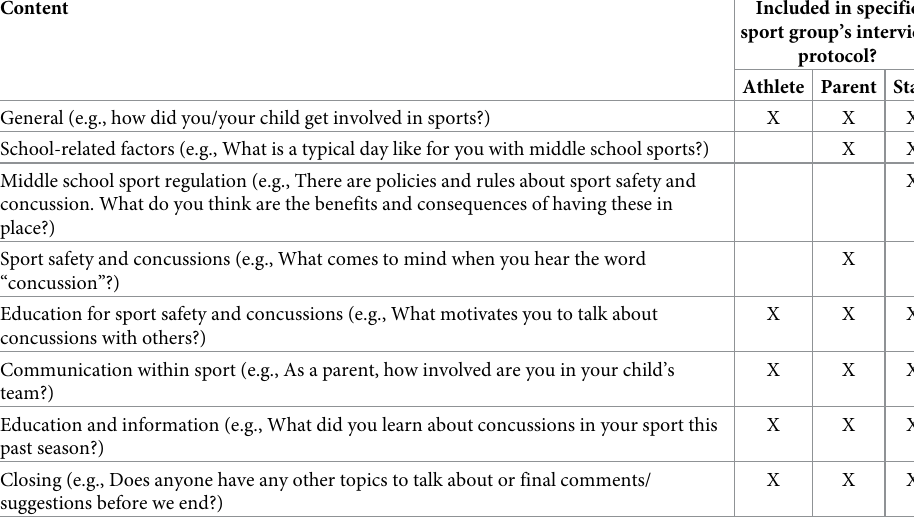
Table 2. Content of semi-structured phone interview with middle school athletes, parents, staff.